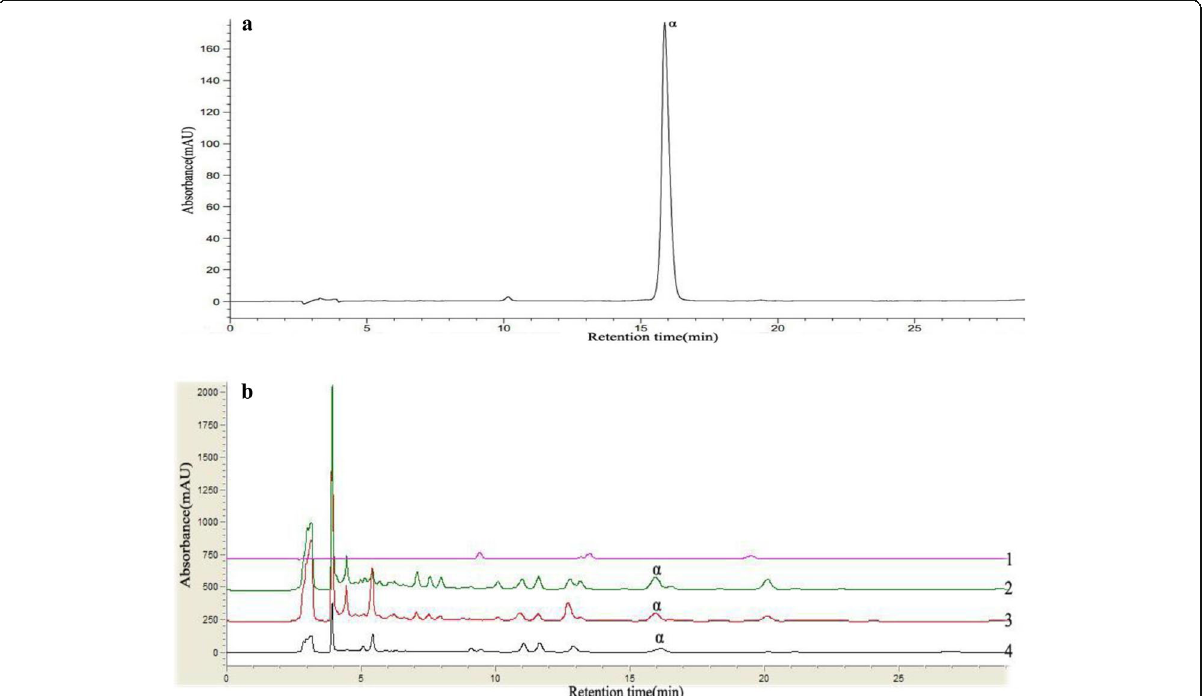
Fig. 1 HPLC chromatograms of ( a ) standard and ( b ) T. asiatica fractions (peak α , Chelerythrine). Petroleum ether fraction (1), Ethyl acetate fraction (2), Methanol fraction (3), and Methanol extract